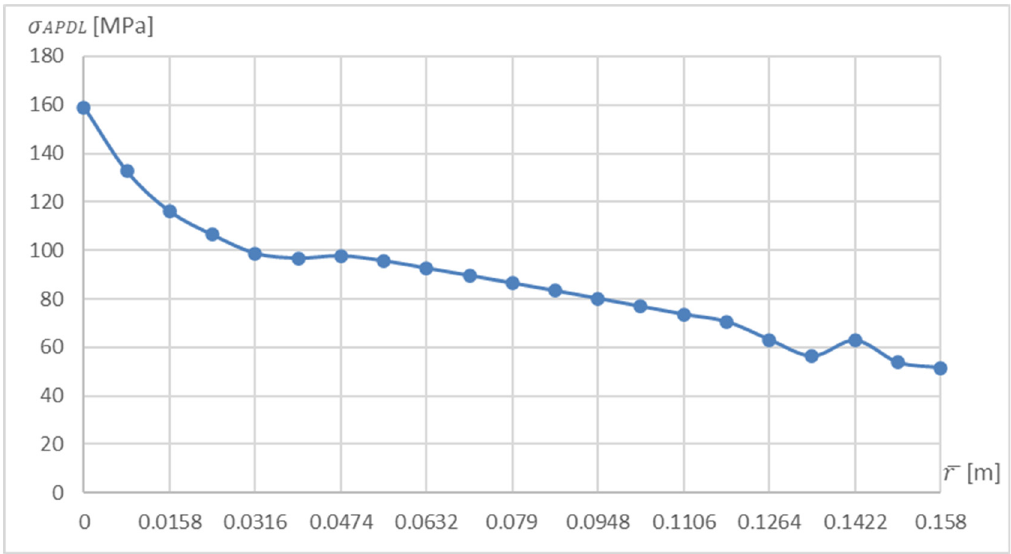
Figure 5. Stress distribution along the first path.